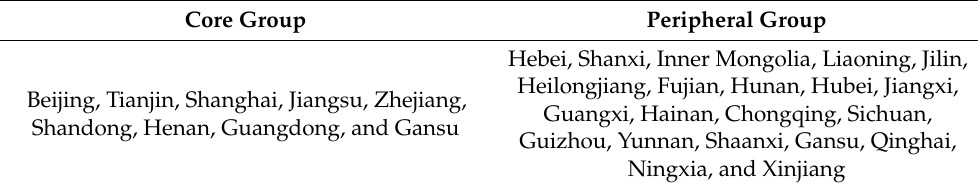
Table 10. Grouping results of the core-periphery analysis. Core Group Peripheral